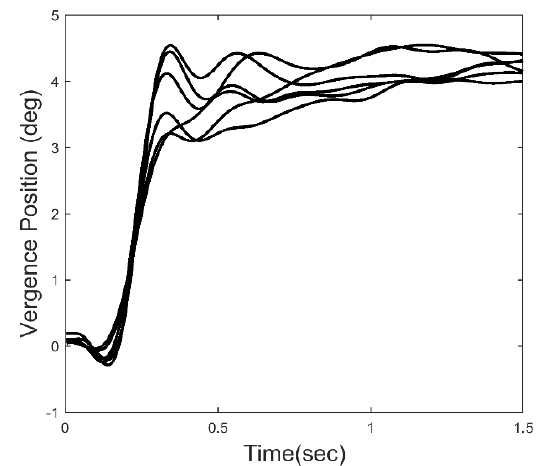
Figure 2: An ensemble of 6 vergence responses to a 4 deg convergent step. The later portion of the responses show what appear to be sustained